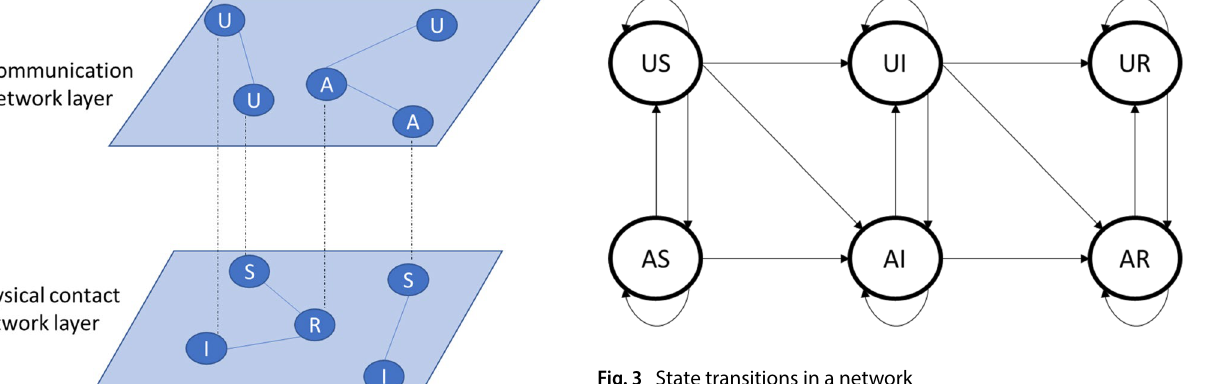
Fig. 3 State transitions in a